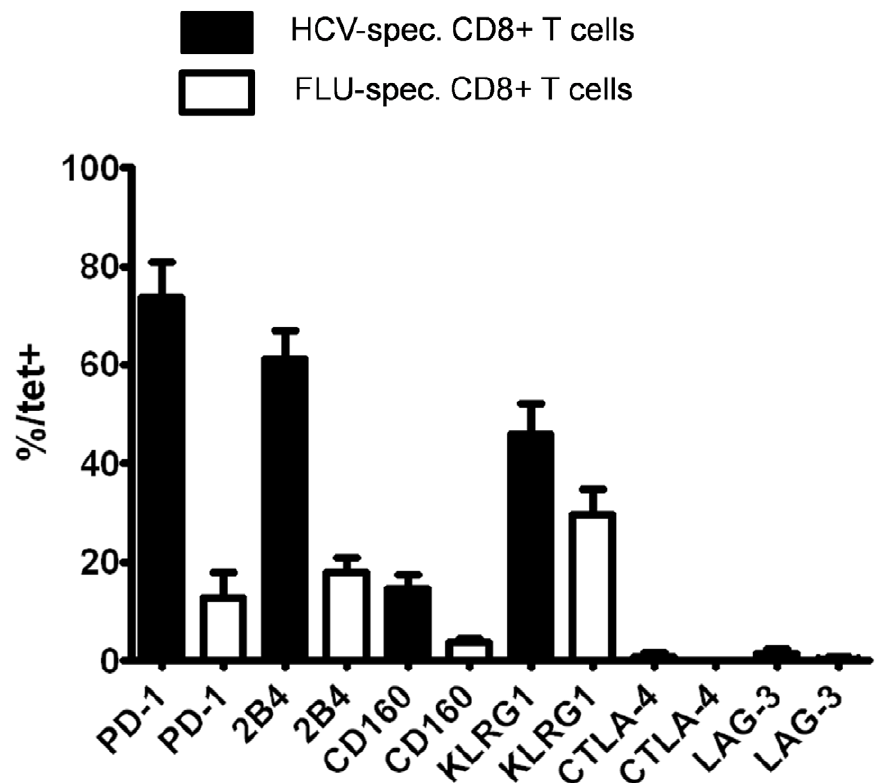
Figure 1. Expression of various inhibitory receptors by HCV-specific CD8 + T cells. The expression of PD-1, 2B4, CD160, KLRG1, CTLA-4 and LAG-3 was monitored on HCV-specific CD8 + T cell responses targeting multiple immunodominant HCV epitopes of 10 consecutive patients and compared to the expression of these receptors on virus-specific CD8 + T cells targeting an immunodominant Influenza matrix epitope. Mean expression and SEM of each inhibitory receptor on virus-specific CD8 + T cells is shown.